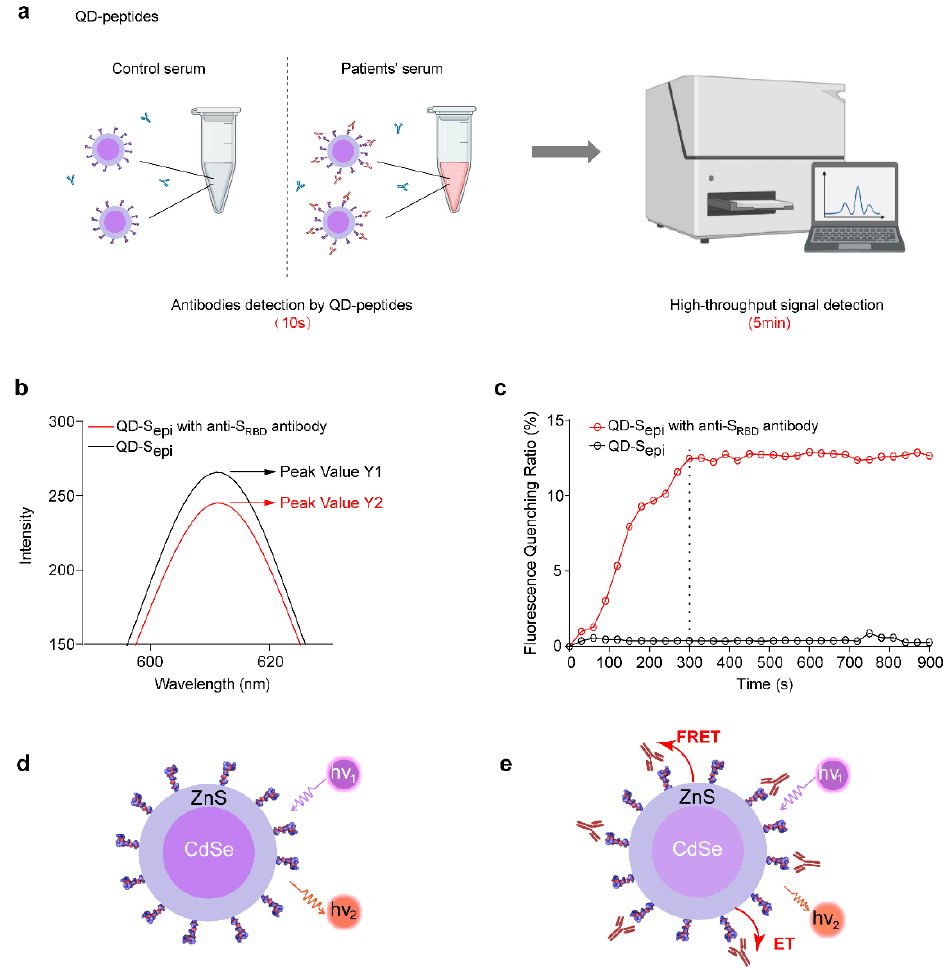
Figure 2. Model of QD-SARS-CoV-2 peptides reacting with the corresponding antibody. ( a ) Schematic diagram of COVID-19 patients’ sera detected by the QD-peptides biosensor. ( b ) Fluorescence intensity of QD-S epi reacting with (red line, peak value Y2) or without (black line, peak value Y1) the anti-S RBD antibody at 608 nm. The fluorescence quenching ratio was defined as (fluorescent peak value Y1 − fluorescent peak value Y2)/Y1 × 100%. ( c ) The time-resolved measurement results of the fluorescence quenching ratio for QD-S epi with (red line) or without (black line) the anti-S RBD antibody. The fluorescence quenching ratio becomes stable in 5 min (300 s) marked by the dashed line. Experiments were repeated three times with similar results. ( d , e ) The sensing mechanism of the QD-peptides biosensor reacting with the corresponding antibody. ( d ) Schematic diagram of the QD-peptides. ( e ) Schematic diagram of the QD-peptides reacting with the corresponding antibody. The dark purple area represents the CdSe core of the QDs, the light purple area represents the ZnS shell of the QDs, and the red area represents the antibody. ET, electron transfer. FRET, fluorescence resonance energy transfer. S epi : S epi1